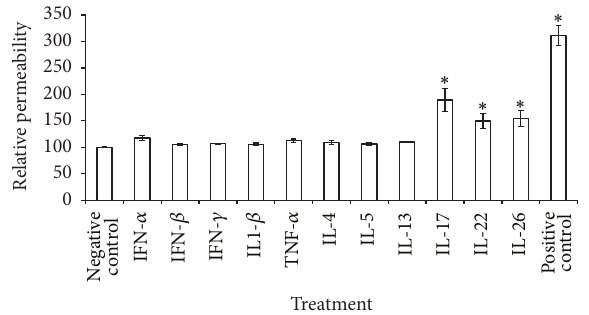
Figure 2: The Th17 cytokines cause an increase in paracellular per- meabilityinCRS.ParacellularpermeabilityofHNECsinALIculture wasdeterminedbyaDextran-FITCassayafter24 htreatmentofTh1, Th2, and Th17 cytokines. The values are shown as means ± SEM for 𝑛 = 4 . Treatments significantly different from the untreated control at 𝑝 < 0.05 are presented as ∗ . ANOVA, followed by Tukey HSD post hoc